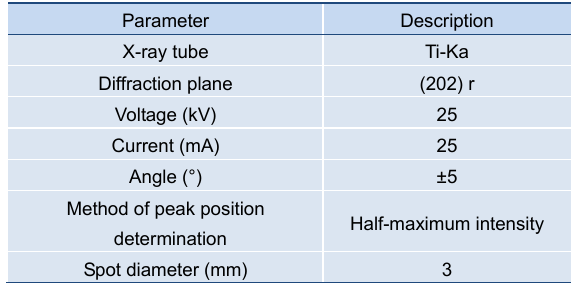
Table 4 | Basic parameters of X-ray diffraction stress measurement.